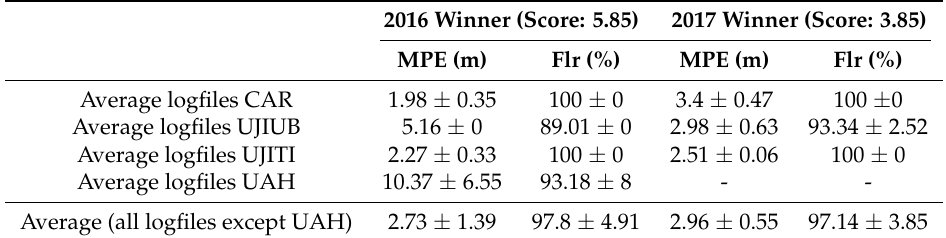
Table 5. Average results of 2016 & 2017 IPIN Competition winners in the different evaluation